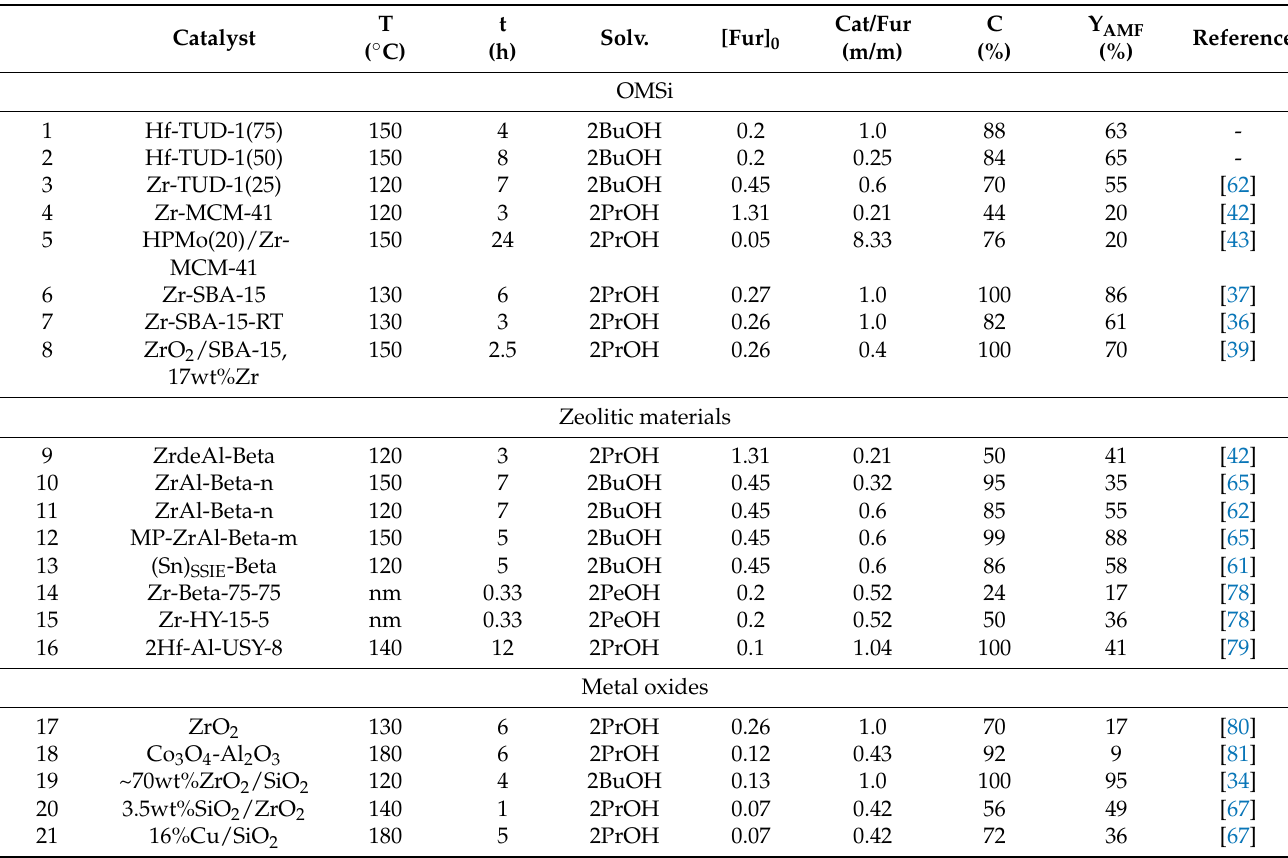
Table 2. Best catalytic results for Hf-TUD-1(x) and comparison with literature data for Fur conversion to AMFs in alcohol medium over fully inorganic heterogeneous non-noble metal catalysts 1